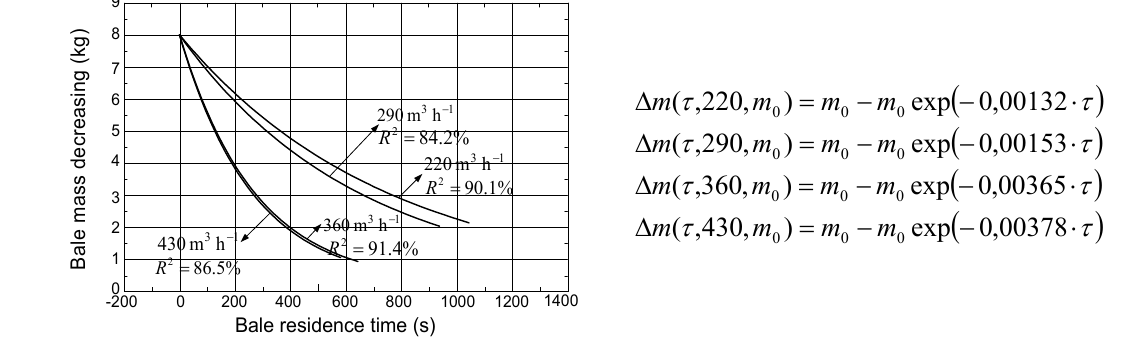
Figure 7. Mass loss rate as a function of time, recirculation 16.5%.